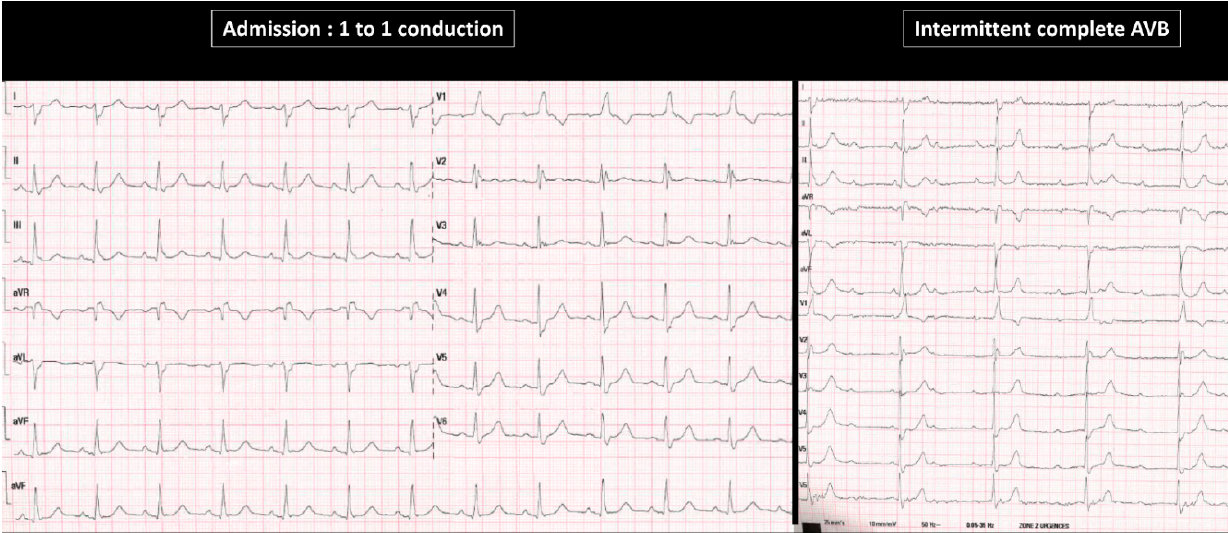
Figure 6. Twelve-lead ECG from an 82 year-old female patient admitted at the emergency department for syncope with cerebral traumatism. The initial ECG shows sinus rhythm with 1 to 1 atrioventricular conduction and complete right bundle branch block associated with left fascicular posterior block. During ECG monitoring at the cardiac care unit, the patient developed an intermittent complete “intrinsic” AVB episode. No trigger of PD-AVB was found in this patient, who was included in the non-PD-AVB group.